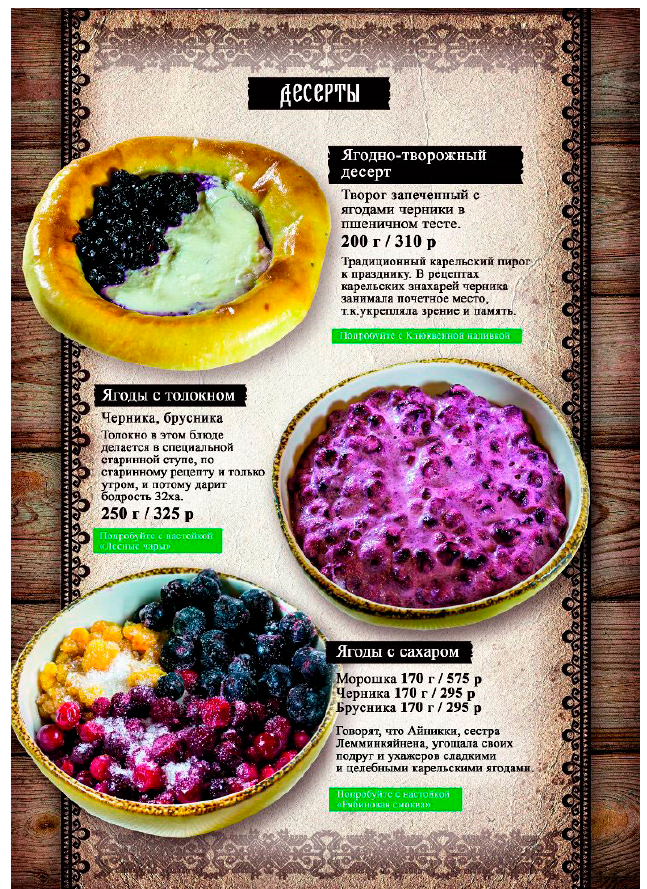
Figure 4. A page from the menu of the restaurant Karel’skaia gornitsa, Petrozavodsk. The second item on the menu: ‘Berries mixed with tolokno . Bilberries, cowberries. Tolokno for this dish is prepared in a special mortar following an old recipe and only in the mornings so that it good at producing high